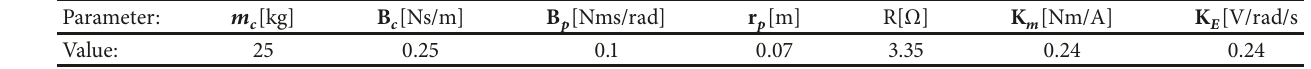
Table 3: Numerical values for the simulation model parameters.